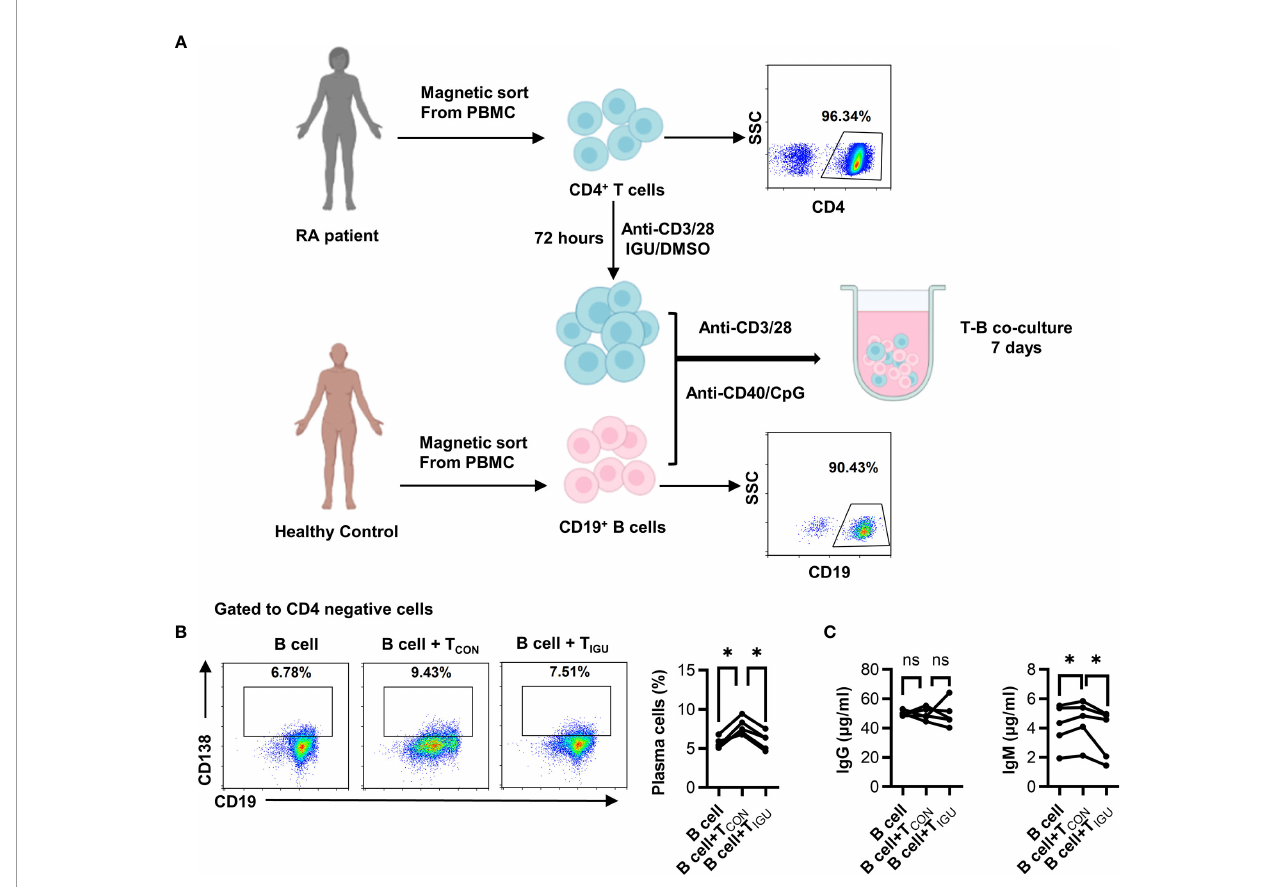
FIGURE 1 | IGU inhibits T cell-dependent antibody production. (A) Puri fi ed RA-CD4 + T cells were cultured in the presence or absence of IGU for 72 hours, then co- cultured with CD19 + B cells from healthy donors for 7 days. The purity of CD4 + T cells and CD19 + B cells were shown. (B) The percentage of plasma cells (CD138 + ) was detected by fl ow cytometry (n = 5). (C) The production of IgG and IgM in the supernatant was detected by ELISA (n = 5). Symbols represent individual subjects. ns, no signi fi cance; * P <